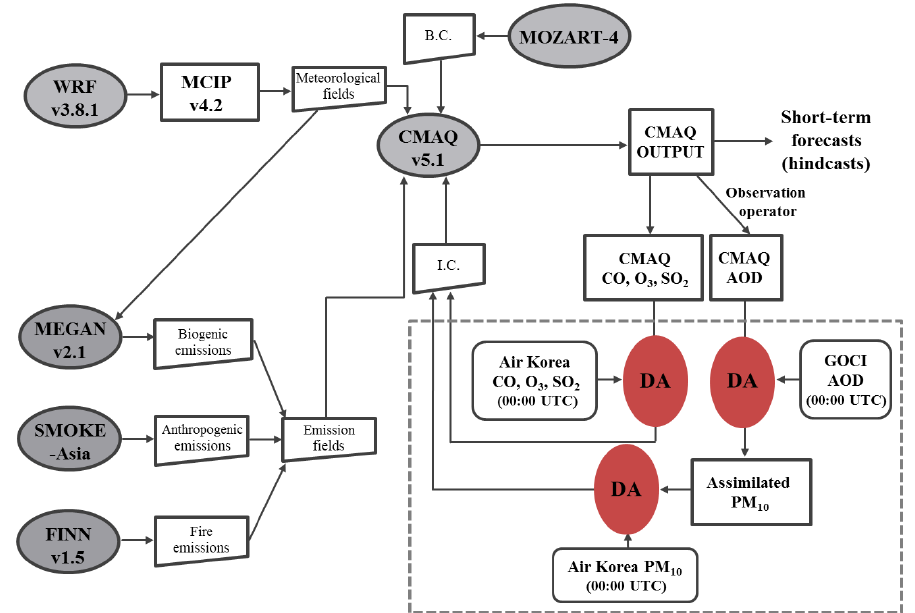
Figure 2. Schematic diagram of the Korean air quality prediction system developed in this study. The initial conditions (ICs) of the CMAQ model simulations are prepared by assimilating CMAQ outputs with satellite-retrieved and ground-measured observations. The data process for preparing the ICs is shown in the box with dashed gray lines.